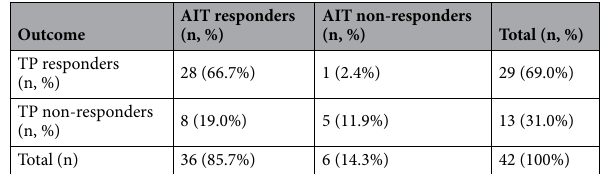
Table 2. Distribution of AIT and TP responders and non-responders. AIT = ab interno trabeculectomy. TP = YAG-assisted